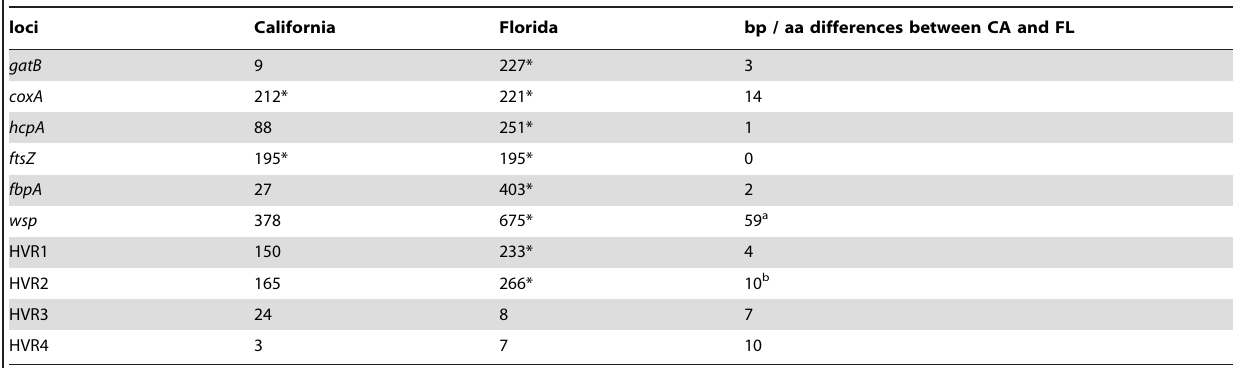
Table 3. Wolbachia MLST